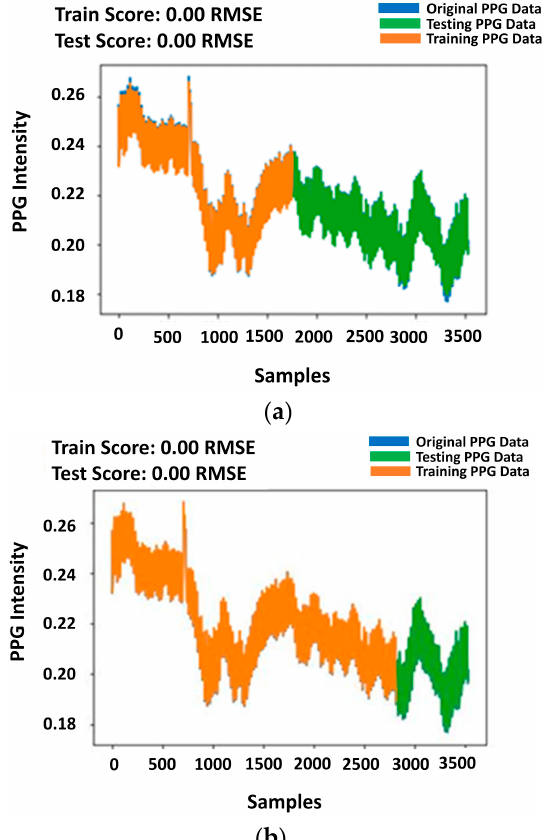
Figure 9. Time series prediction with Bi-LSTM using two different training/testing splitting ratios ( a ) 50/50 and ( b ) 80/20 in Subject 3 ′ s PPG data from Figure 2.